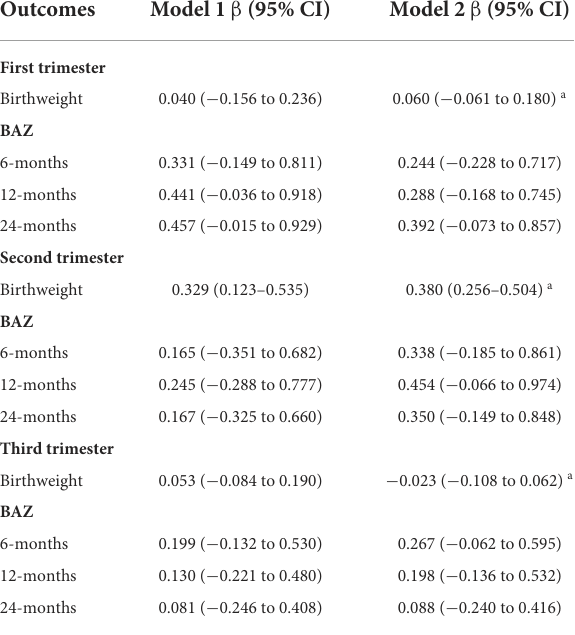
TABLE 5 Unadjusted and adjusted correlations between excessive or inadequate trimester GWGR and LGA and age-specific overweight.